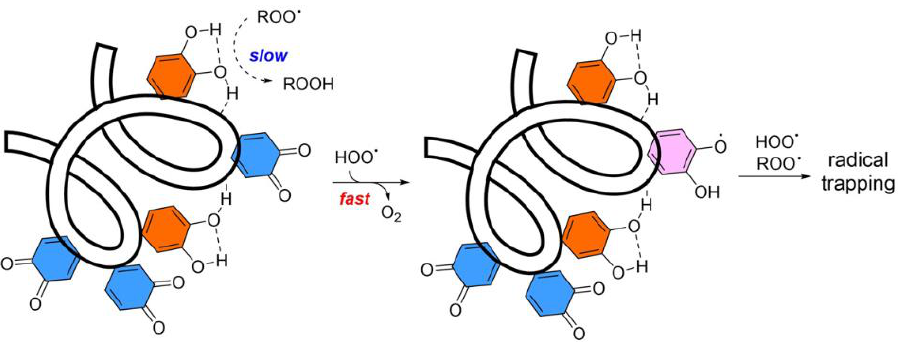
Figure 2. Catechol (orange) and quinone (blue) units in the polydopamine polymer are unreactive toward alkyl-peroxyl radicals (ROO · ), but upon the reaction with HOO • , the quinones are converted to ortho-semiquinone radicals (pink) with an enhanced ability to trap both species, HOO • or ROO • . Reprinted with permission from ref.